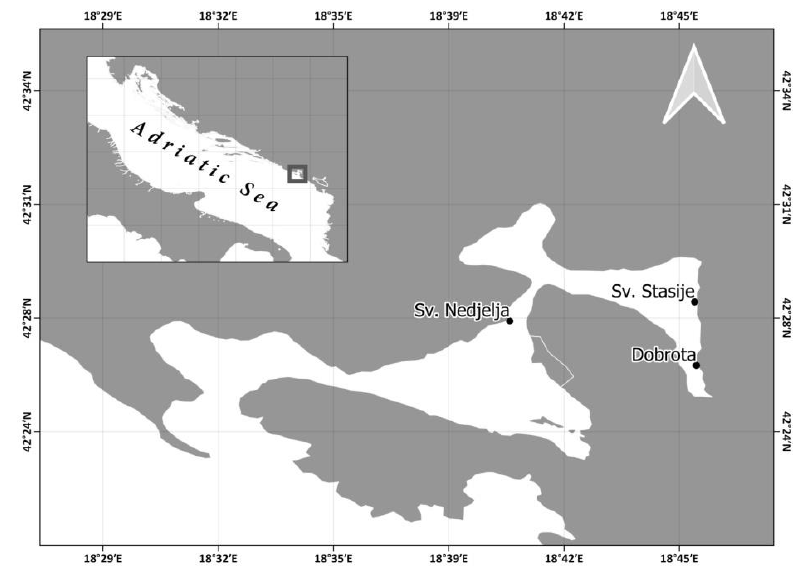
Figure 1. Sampling sites in the Boka Kotorska Bay, Montenegro.